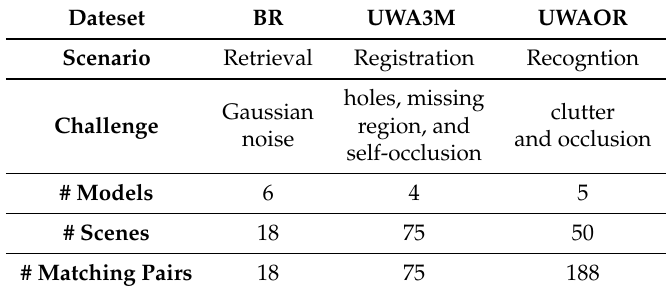
Figure 5. Two exemplar models and scenes without noise (shown from left to right), respectively, taken from the BR, UWA3M, and UWAOR datasets. Table 1. Experimental datasets and inherited